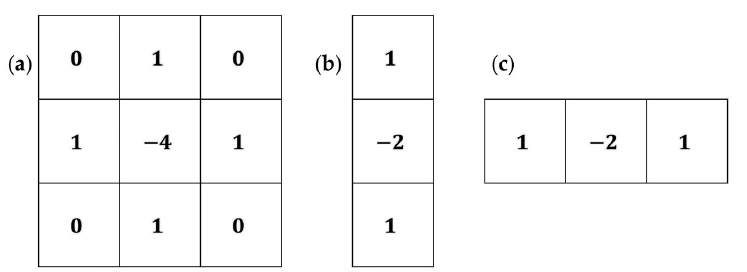
Figure 2. The templates of Laplacian operator: ( a ) is the template for the internal grids; ( b , c ) are for the boundary grids.